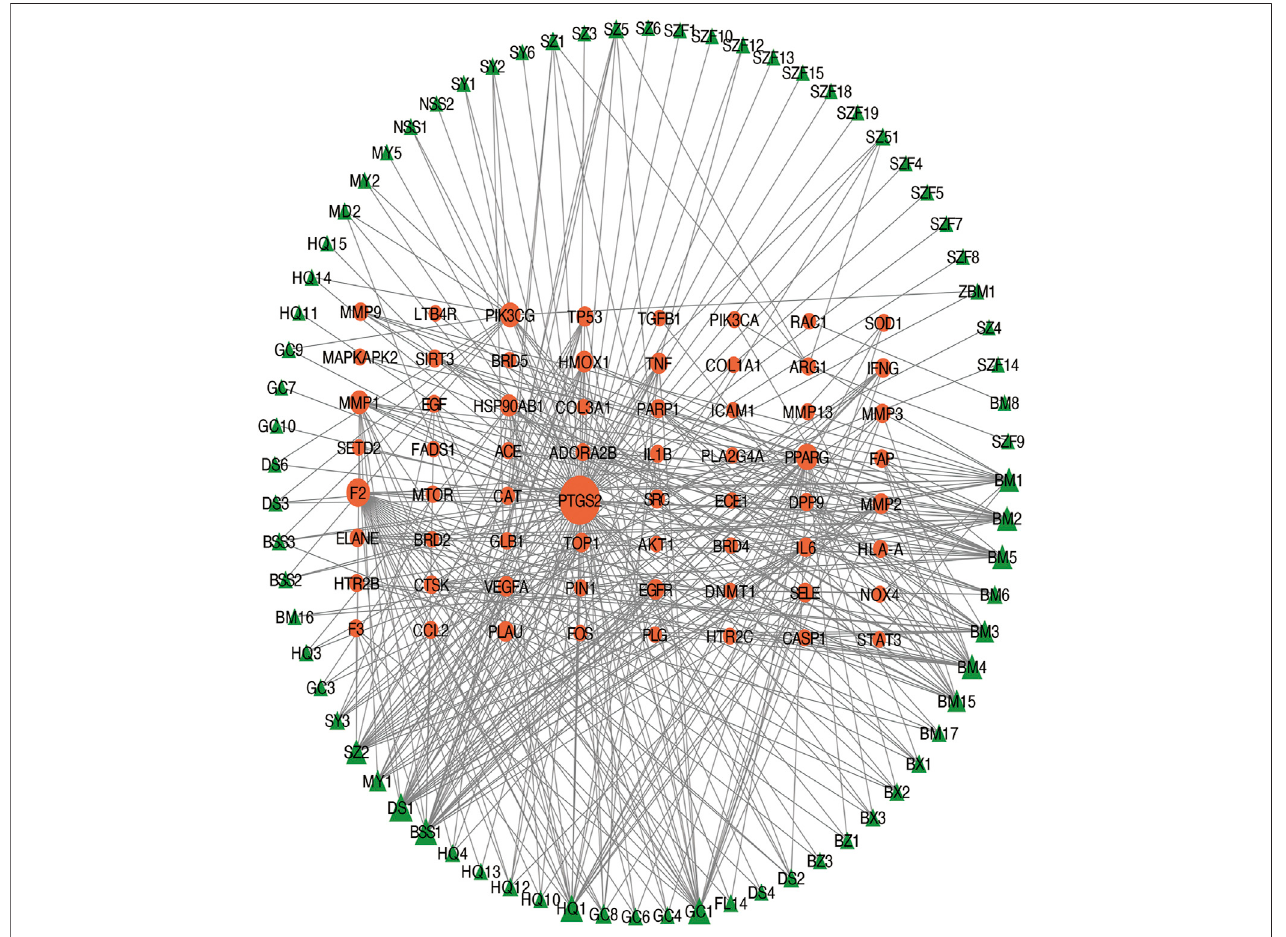
FIGURE 3 | Construction of the drug (herbal ingredients) – disease (pulmonary fi brosis targets) network. The nodes representing drug candidate compounds are shown as green triangles and the targets are indicated by orange circles.